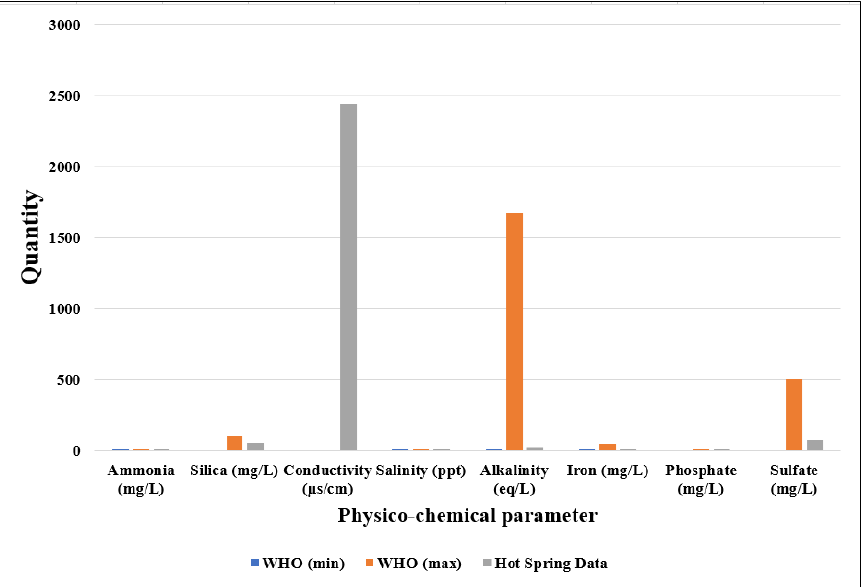
Figure 4. The comparison of the concentrations of chemicals in the hot springs and the WHO standards for swimming water.